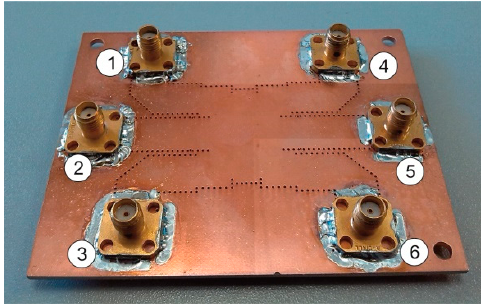
Figure 7. Photograph of the prototype of the six-port coupler. Figure adapted from [36].